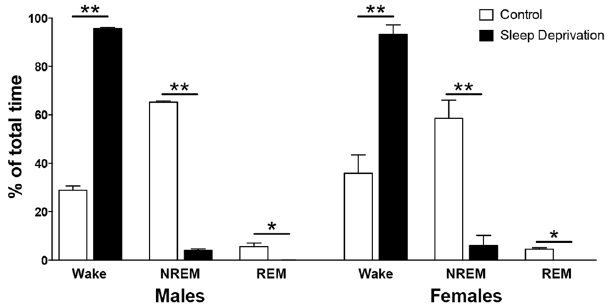
Figure 2. Gentle handling for 6 h from ZT 0 to ZT 6 effectively eliminates rapid eye movement (REM) and non- REM (NREM) sleep in male and female animals. All data are mean ± SEM. * P < 0.05, ** P < 0.01. N = 3 per